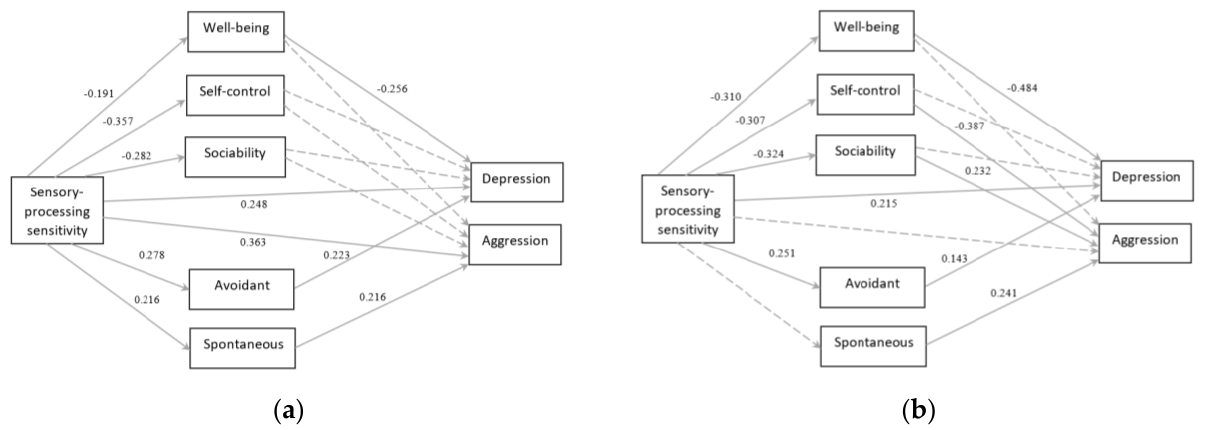
Figure 3. Results for the path analysis for: ( a ) men; ( b ) women. Entries are standardized regression weights. Discontinuous lines represent non-significant paths.